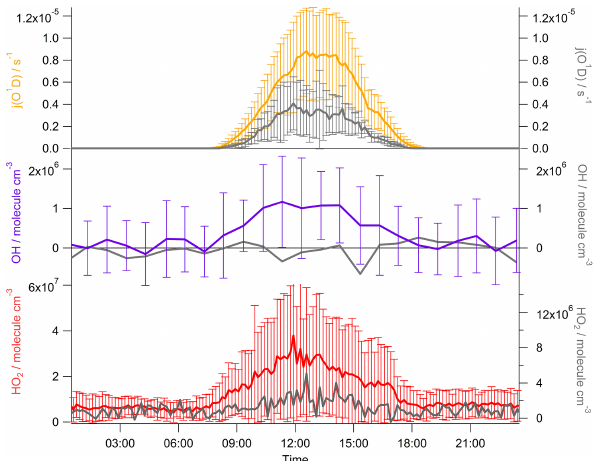
Figure 3. Average diurnal profiles of j (O 1 D, OH and HO 2 in cloud (grey) and out of cloud (coloured). The error bars represent the 1 σ variability of the averaged data; only the variability in the out-of- cloud radical data is shown for clarity. Each data point represents 10min averaged data apart from the OH, for which the hourly aver- aged data are given.